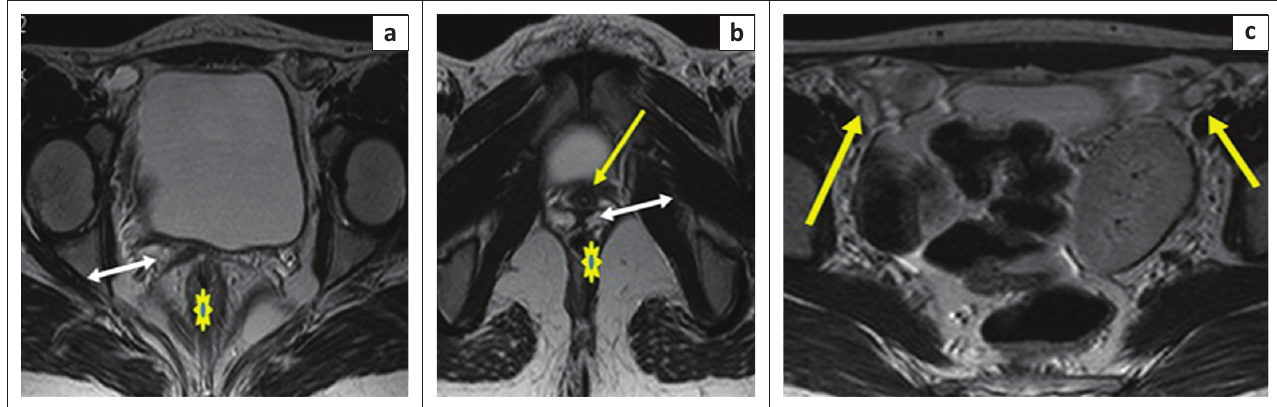
FIGURE 16: Axial T2 sequence (a) demonstrates a band of vagina (double-headed white arrow) in between the rectum (asterisk) and urethra (yellow arrow). Axial T2 sequence (b) identifies both ovaries (yellow arrows) and a left pelvic kidney. Mayer–Rokintasky–Küster–Hauser syndrome.